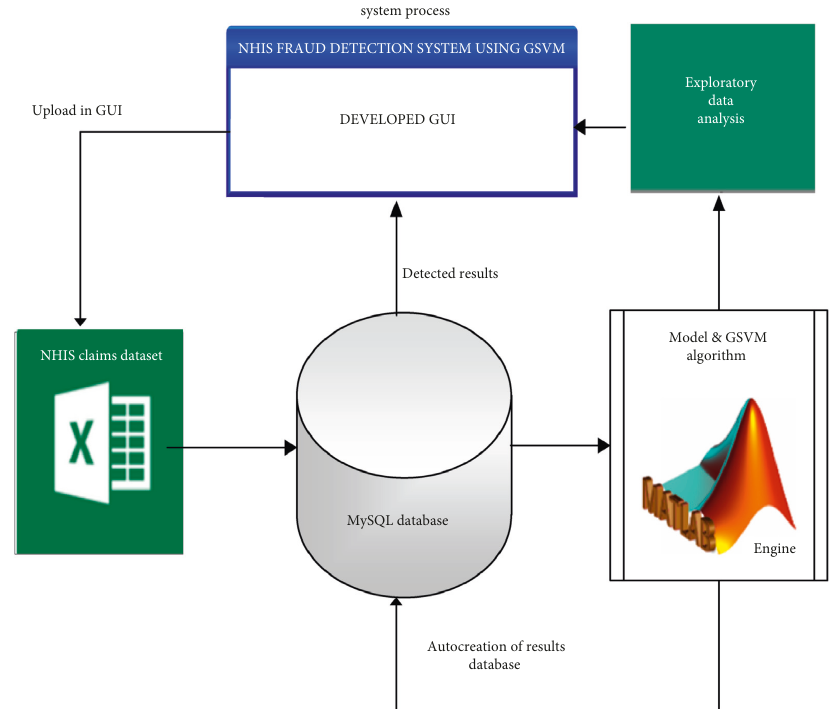
Figure 8: System implementation architecture for HICFDS.